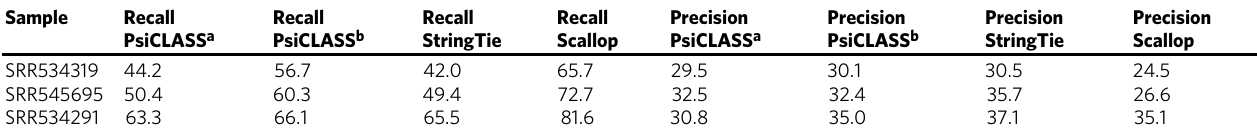
Table 2 Performance of methods on experiments with small numbers of samples on real data